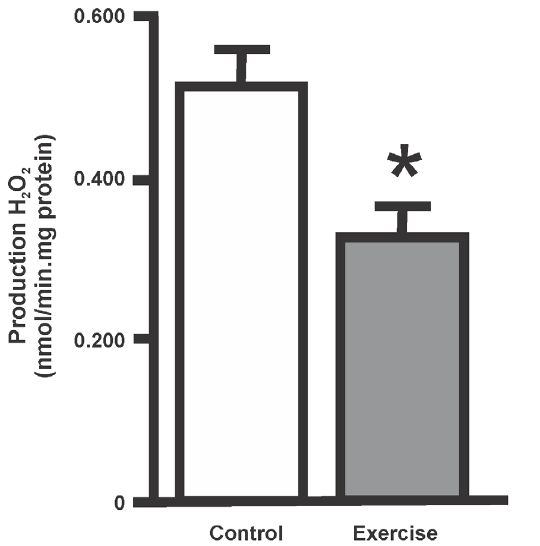
Figure 4. Bar scheme of H 2 O 2 production rate of human placental mitochondria from exercised or control subjects. Data are expressed as mean 6 SEM of 4–6 mitochondrial samples for each condition. (*p , 0.05, as compared with control value).